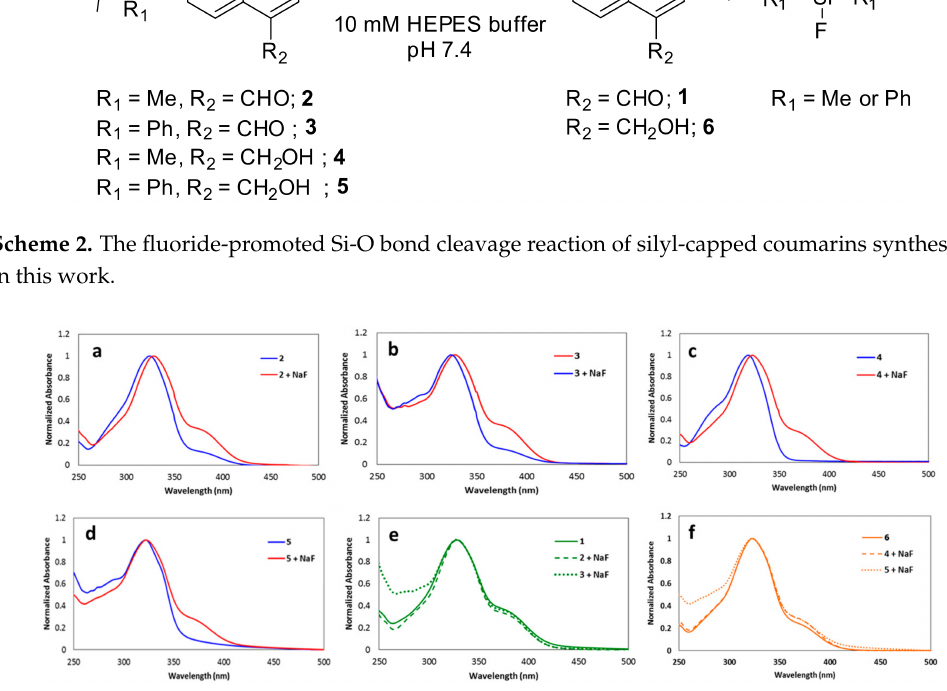
Figure 2. ( a – d ) The normalized UV-Vis absorption spectra of 2 ( a ), 3 ( b ), 4 ( c ), and 5 ( d ) (7.2 µ M) in HEPES buffer pH 7.4 (contain 3% MeCN) before (blue line) and after (red line) incubation with NaF (12.5 mM) for 1 h (the absolute absorption spectra are shown in Figures S19–S22 in the SM) and ( e , f ) the UV-Vis absorption spectra of 2 , 3 , 4 , and 5 (7.2 µ M) in HEPES buffer pH 7.4 (contain 3% MeCN) after incubation with NaF (12.5 mM) for 1 h compared with the UV-Vis absorption spectra of the corresponding non-silylated coumarins 1 ( e ) and 6 ( f